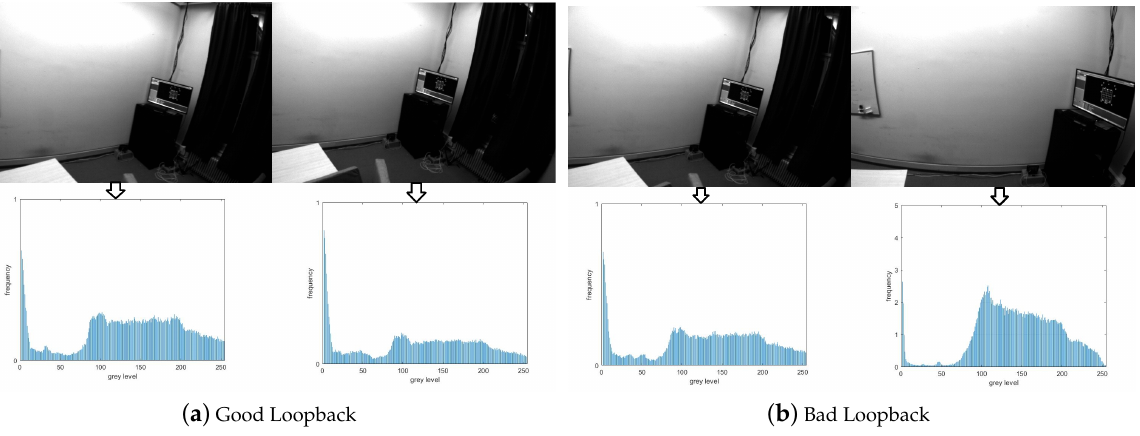
Figure 9. Pairs of keyframes detected by loop closures in V203 sequences and their grayscale histograms. ( a ) Good loopback situation. The loopback detection thread can usually complete the loopback here. ( b ) Bad loopback situation. The loopback detection thread is prone to loopback rejections